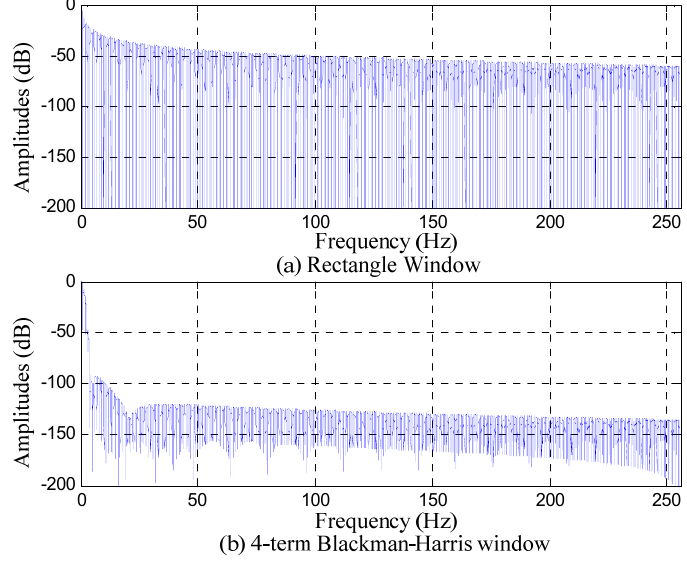
Figure 24. Attenuation of interference leakage on direct current (DC) component by different windows: ( a ) rectangle window; and ( b ) four-term Blackman-Harris